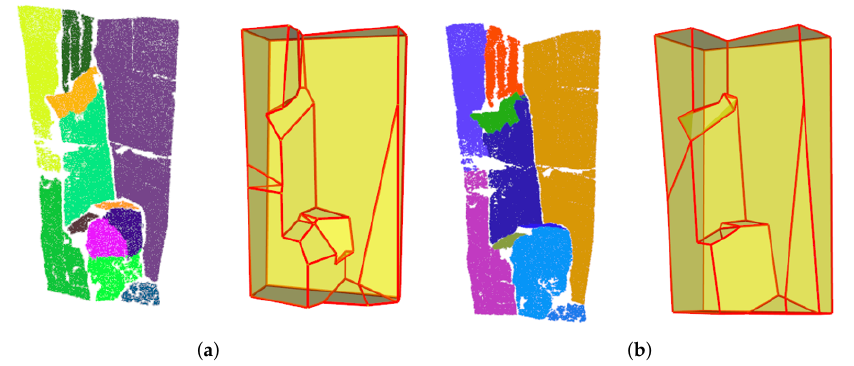
Figure 11. Segmentation and reconstruction results obtained using different region growing parame- ters. ( a ) grow dis = 0.18, grow ang = 13 ◦ . ( b ) grow dis = 0.23, grow ang = 18 ◦